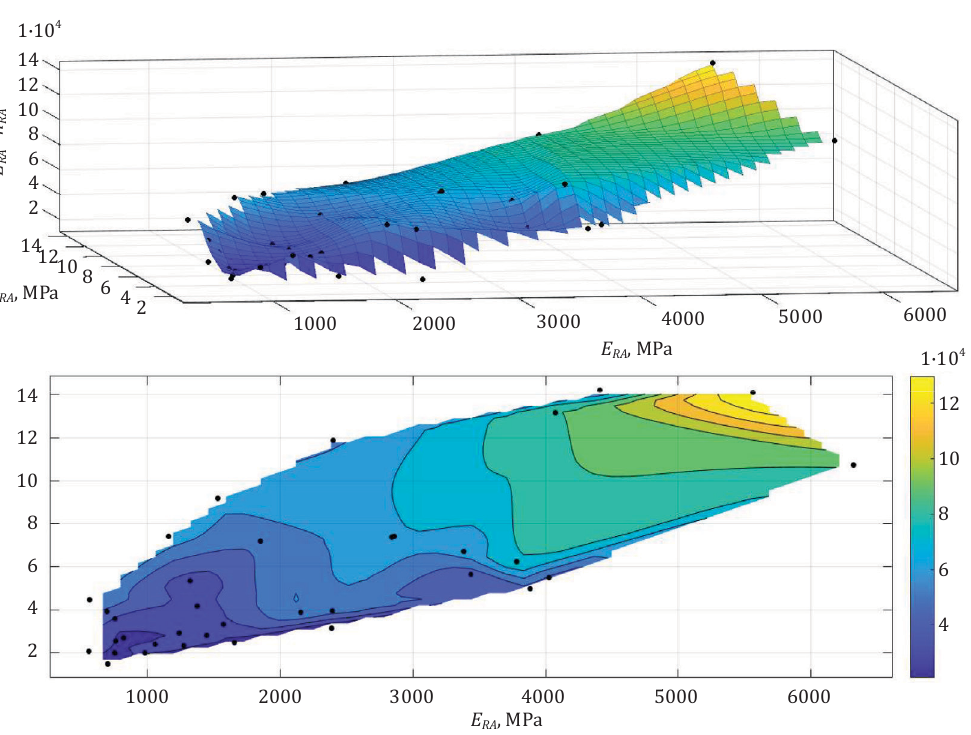
Figure 7. Data approximation using the measured